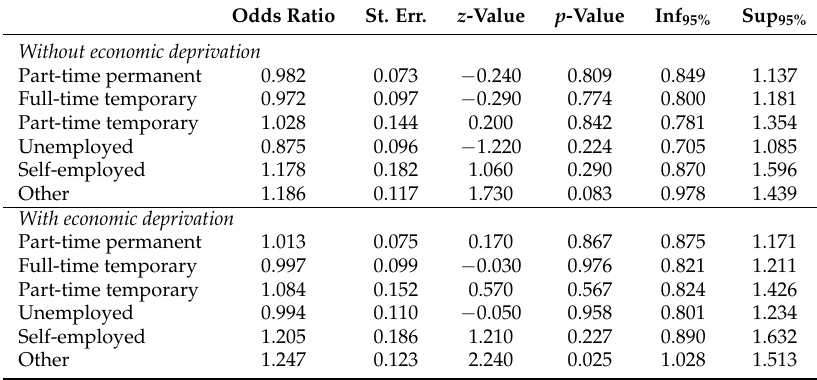
Table 8. Correlated random-effects ordered logit model: estimated odds ratios for employment status (ref.: Full-time permanent)—Continental countries. Odds Ratio St.